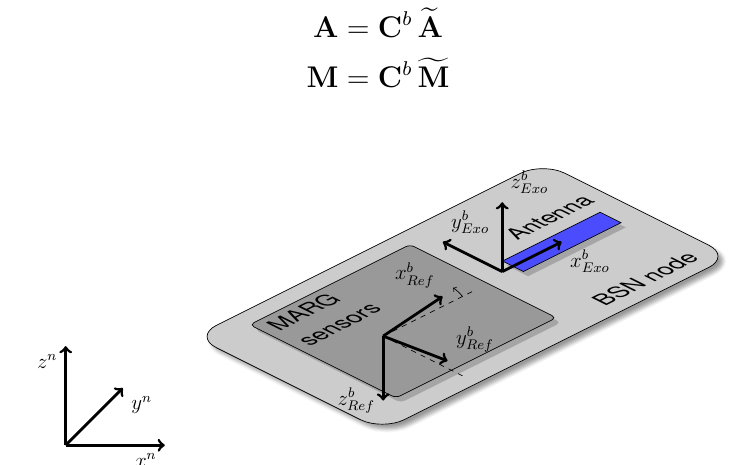
Figure 7. BSN node with mounted MARG sensor extension, different body coordinate frames B and B and calibration platform-based navigation frame N Exo Ref